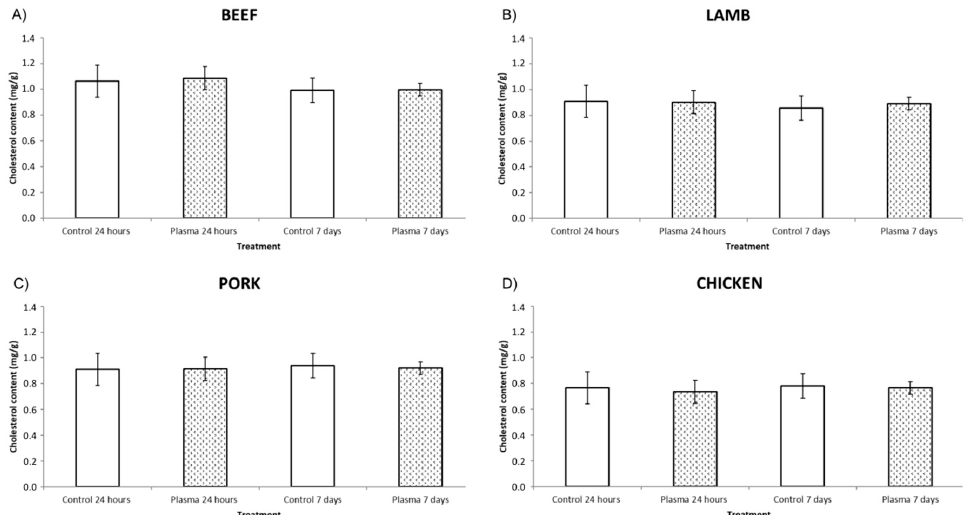
Figure 4. Cholesterol content of control and plasma samples for: ( A ) Beef, ( B ) Lamb, ( C ) Pork, ( D ) Chicken. No significant di ff erences between control and treated sample ( p > 0.05). All the differences